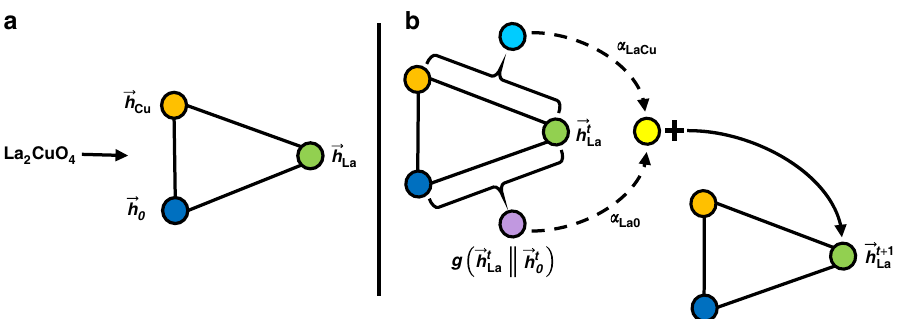
Fig. 1 Schematic representation of stoichiometry graph and update rule. a An example stoichiometry graph for La 2 CuO 4 . b A graphical representation of the the update function for the La representation. The pair dependent perturbations, shown as the cyan and purple nodes, are weighted according to their attention coef fi cients before being used to update the